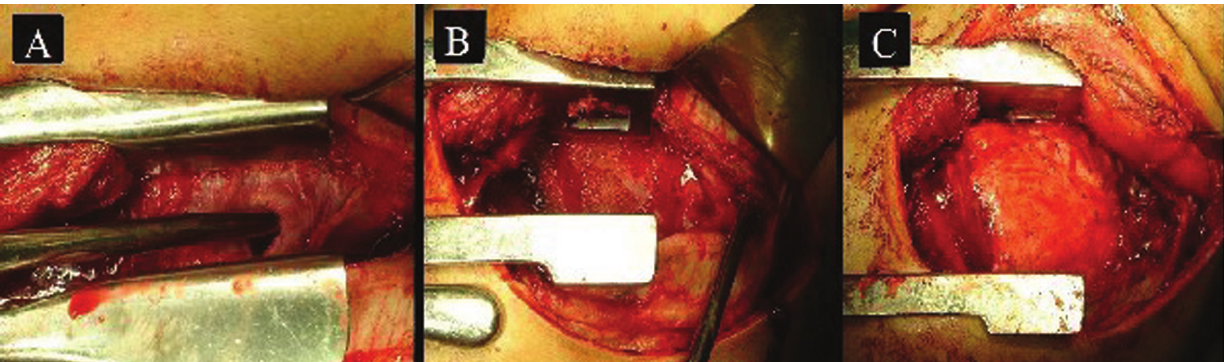
Figure 1 - A. Chronic empyema. Note the thickness and fibrotic nature of the pleural cortex. B. Purulent material has been removed and the visceral pleural cortex can be observed on the bottom, where it restricts lung expansion. C. The lung has been completely decorticated and there is no residual dead